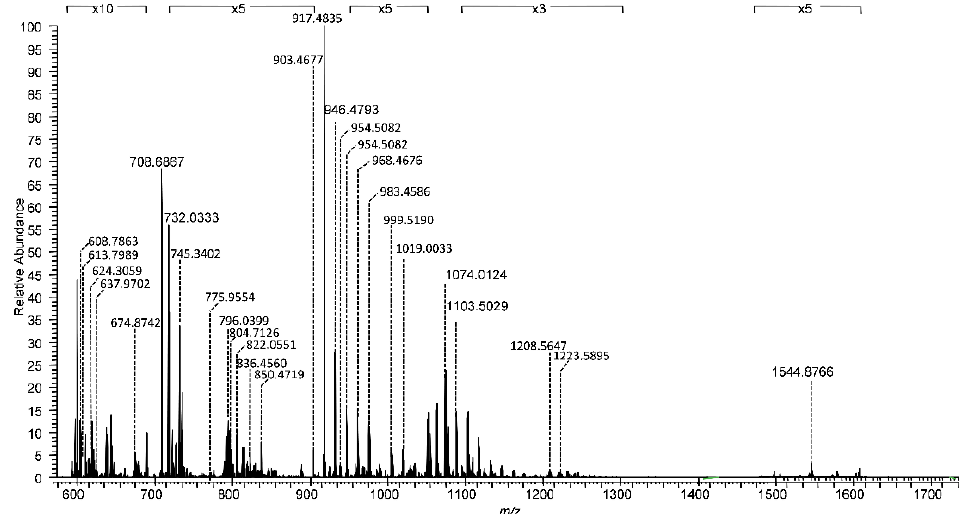
Figure 2. ( − ) NanoESI HR MS of ganglioside mixture isolated from human hippocampal tissue sample in temporal epilepsy. Sample concentration: 5 pmol · µ L − 1 in MeOH; spray voltage: 0.70 kV; cone voltage: − 30 V; acquisition time: 2 min.